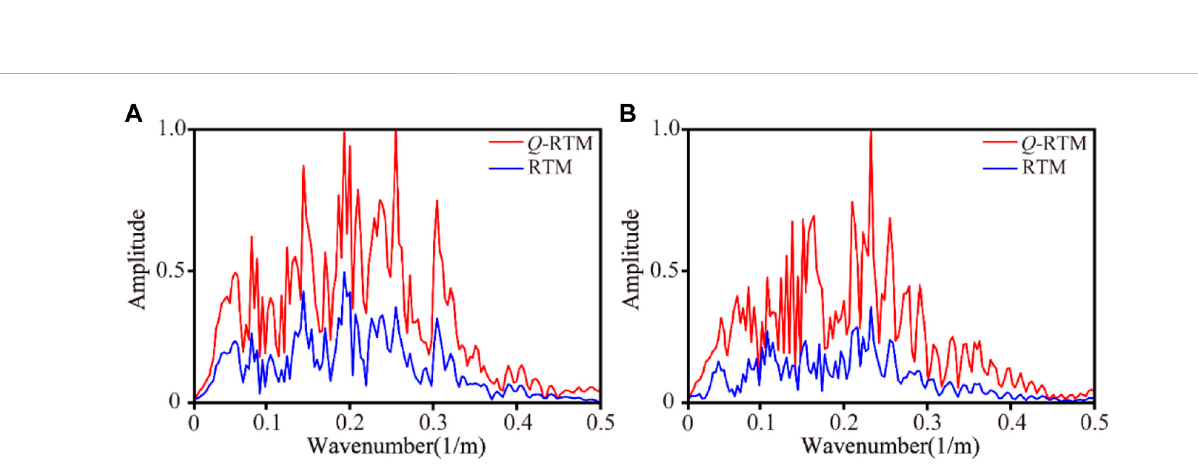
TABLE 1 Calculation-time comparison between different RTM schemes. Modeling